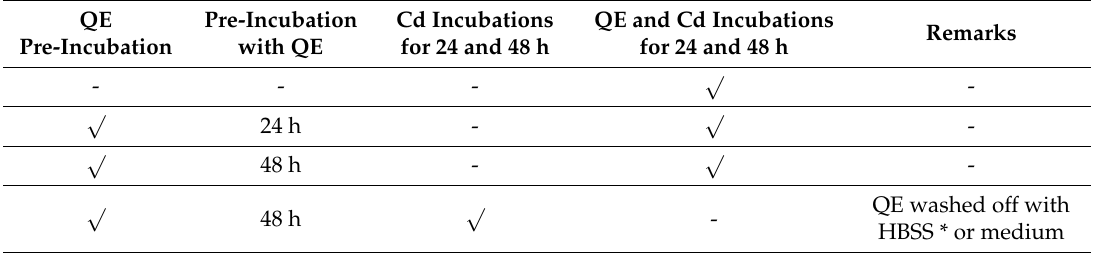
Table 1. Combined incubations of 1321N1 cells with QE and/or